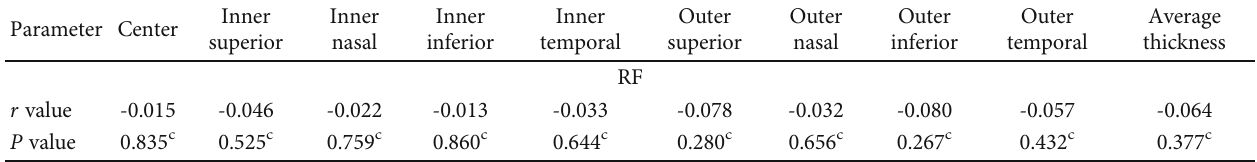
Table 4: The relationship of serum RF with retinal thickness.